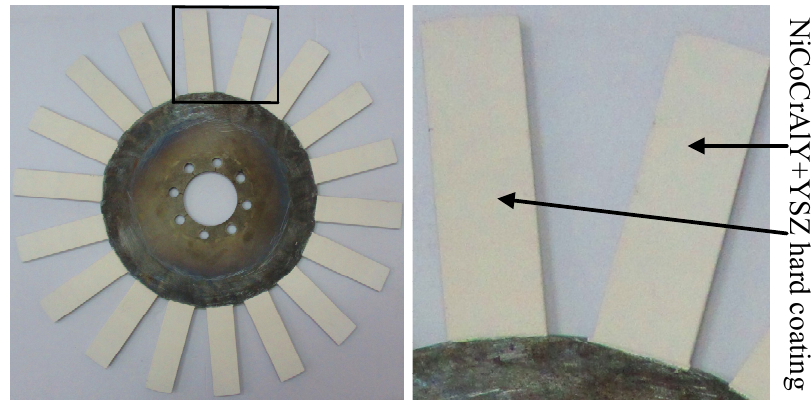
Figure 4. The blisk with the deposited NiCoCrAlY + YSZ hard coating on its blades. Table 1. Geometry parameters of the blisk with hard ‐ coating blades.